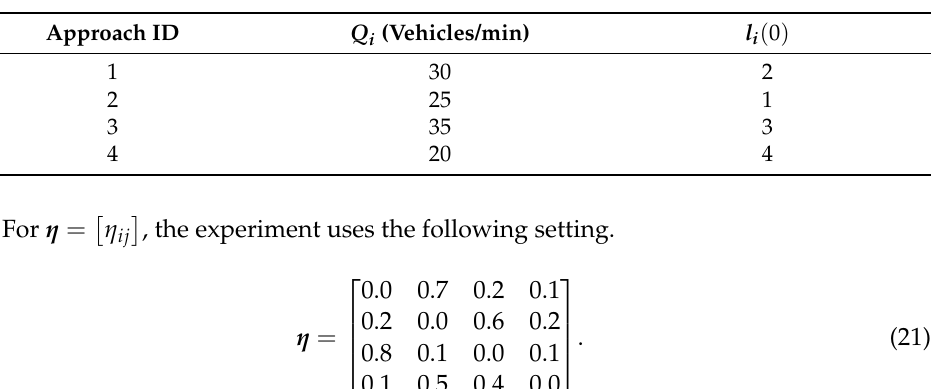
Table 1. Experiment